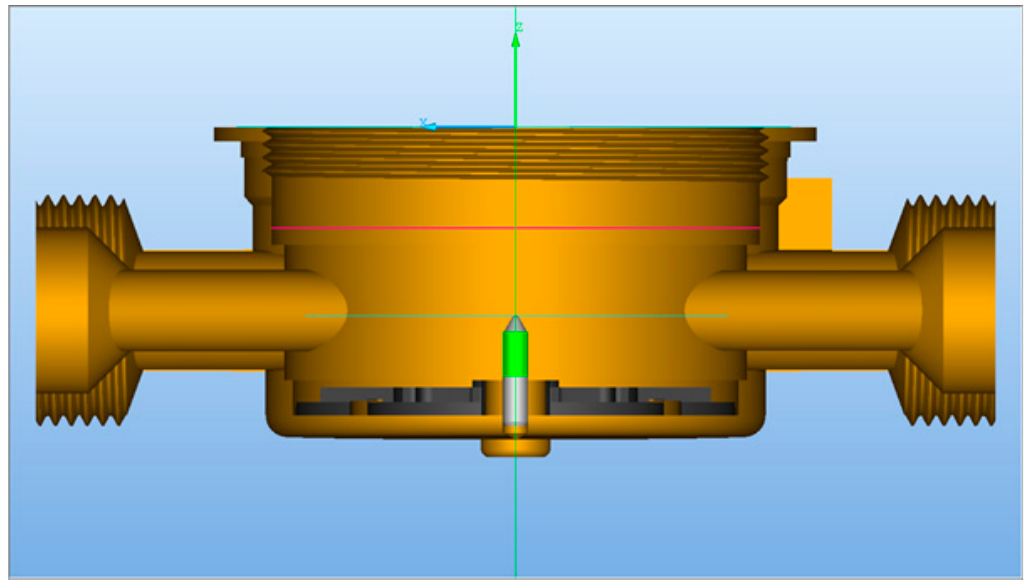
Figure 1. Determination of the radial runout after the assembly process. Construction of the assembly line and its elements is shown in detail in Figure 2.